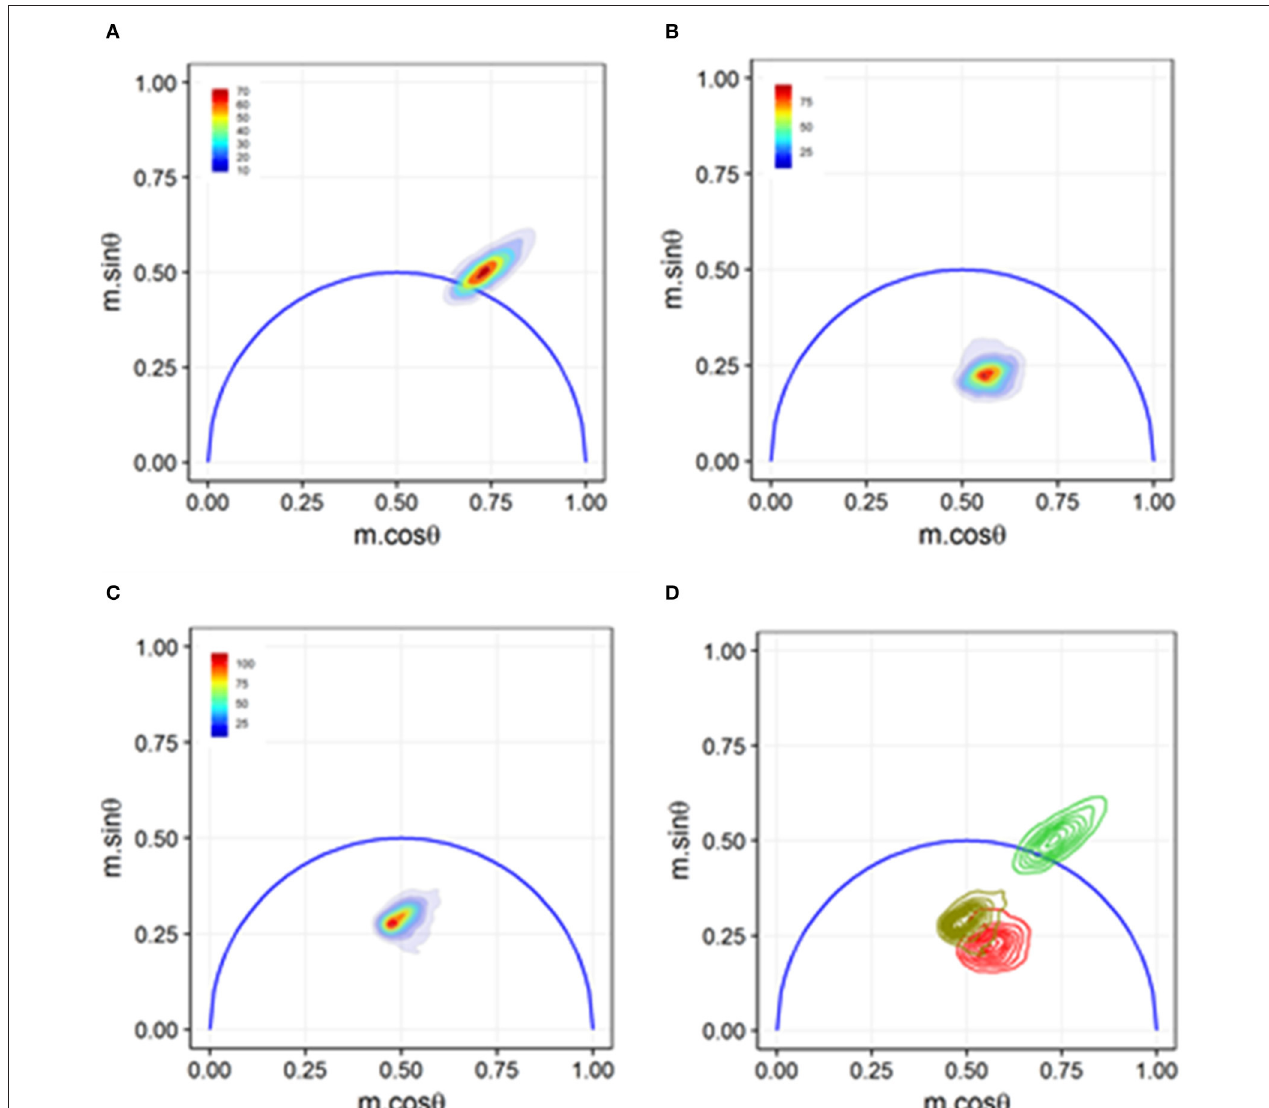
FIGURE 8 | Phasor graph analysis for a Förster resonance energy transfer (FRET) study that resolved integrin conformational changes in the presence of artificial stimuli. (A) Transfected U937 1 ST cells were labeled with conjugated donor probe Leucine-Aspartic Acid-Valine binding residue conjugated to fluorescein isothiocyanate (LDV-FITC). The LDV residue has an affinity for the binding site on the inactive α 4 integrin. (B) Acceptor probe PKH-26 (red, lipophilic fluorescent cell membrane dye), which binds to the cell membrane, was introduced to the cell suspension. Immediate quenching occurs because of the proximity of the donor probe to the acceptor probe. The population transits to the center of the phasor graph, indicating the presence of multiple fluorescence lifetimes as some cells are undergoing FRET and some are unaffected. (C) Artificial stimuli formyl Methionine-Leucine-Phenylalanine-Phenylalanine (fMLFF) elicits activation of α 4 integrins. Integrins extend to their activated state, effectively removing the donor probe out of the proximity of the acceptor probe. Significant heterogeneity was present due to cell response or lack thereof to the artificial stimuli. (D) Contour plots illustrating the distribution and overlap of FRET and loss of FRET populations. Noticeable shifts were seen between the two populations, indicating a general response to the artificial stimuli. Figure adapted with permission from The Optical Society ®